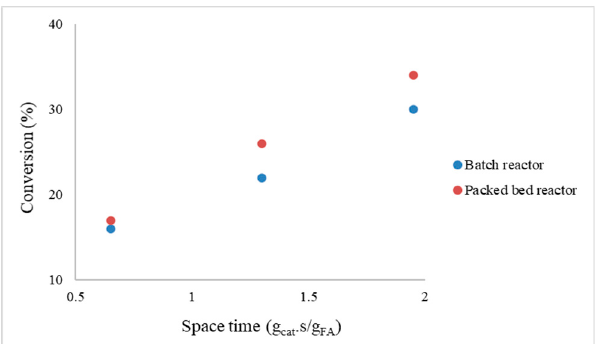
Figure 10. Comparison of a batch reactor and packed bed microreactor. Reaction conditions: Packed bed microreactor: temperature = 30 °C; pressure = 1 bar; inlet flow = 0.05 mL/min; 0.1 g catalyst of 5 wt.% Pd on Carbon. Batch stirred reactor: temperature = 30 °C; pressure = 1 bar; stirring rate = 750 rpm, formic acid = 12 g, 5.3 mg catalyst 5% Pd on carbon).